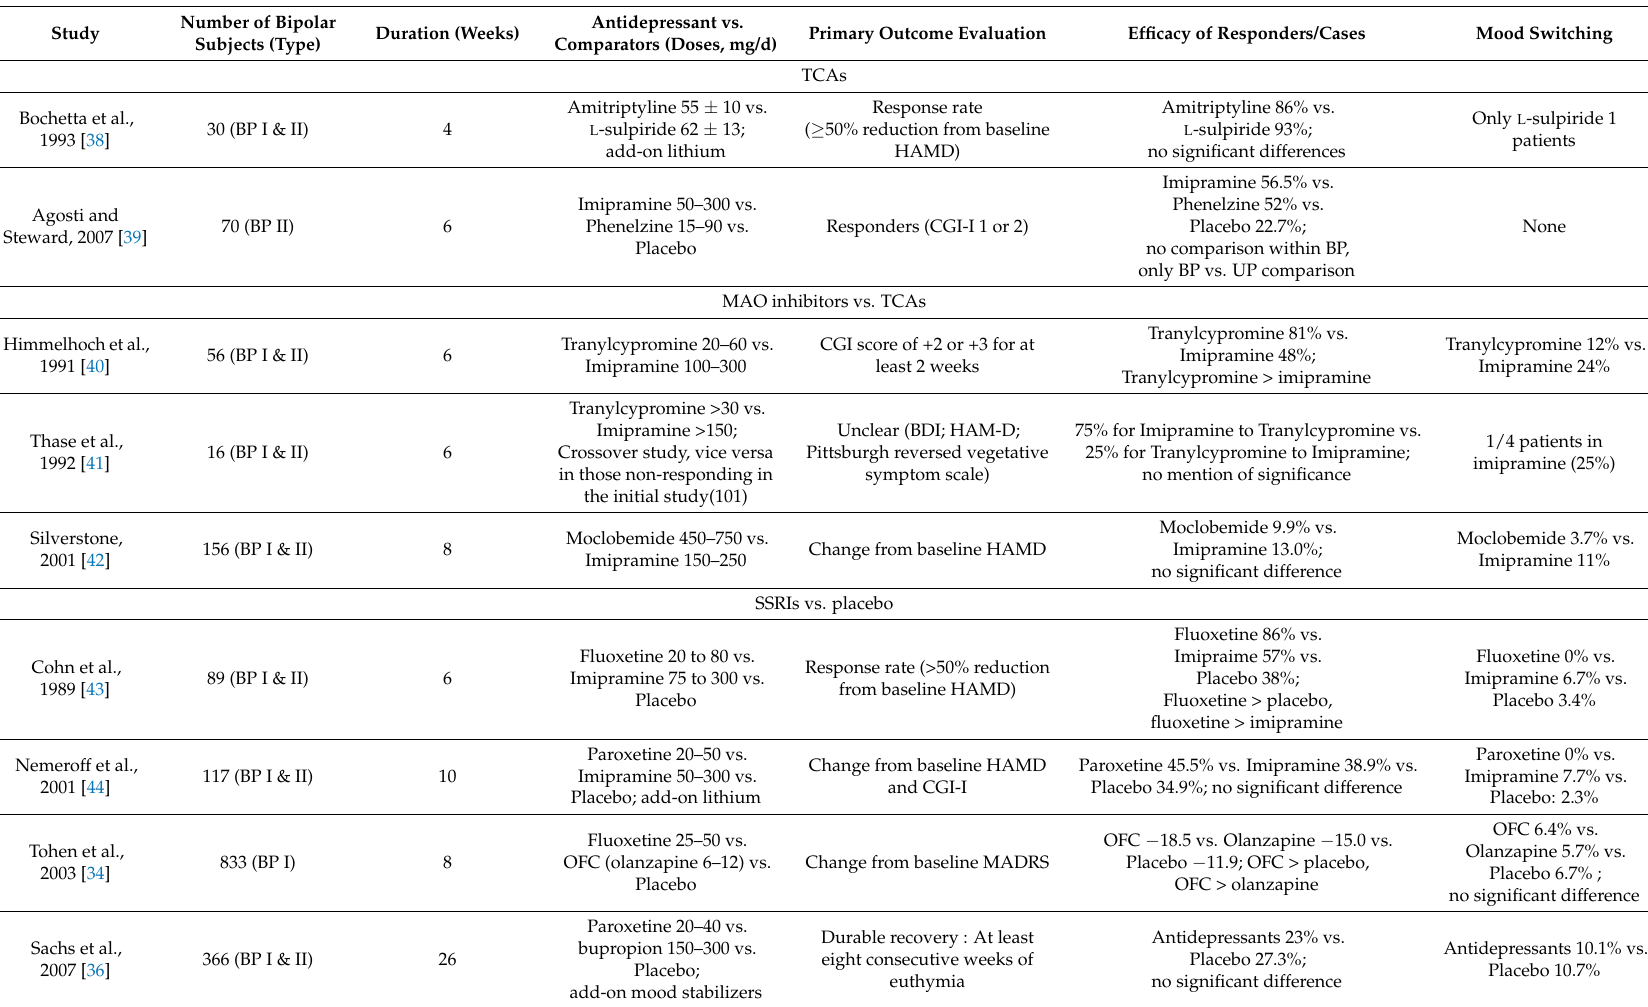
Table 1. Randomized controlled trials of antidepressant use in acute phase in bipolar